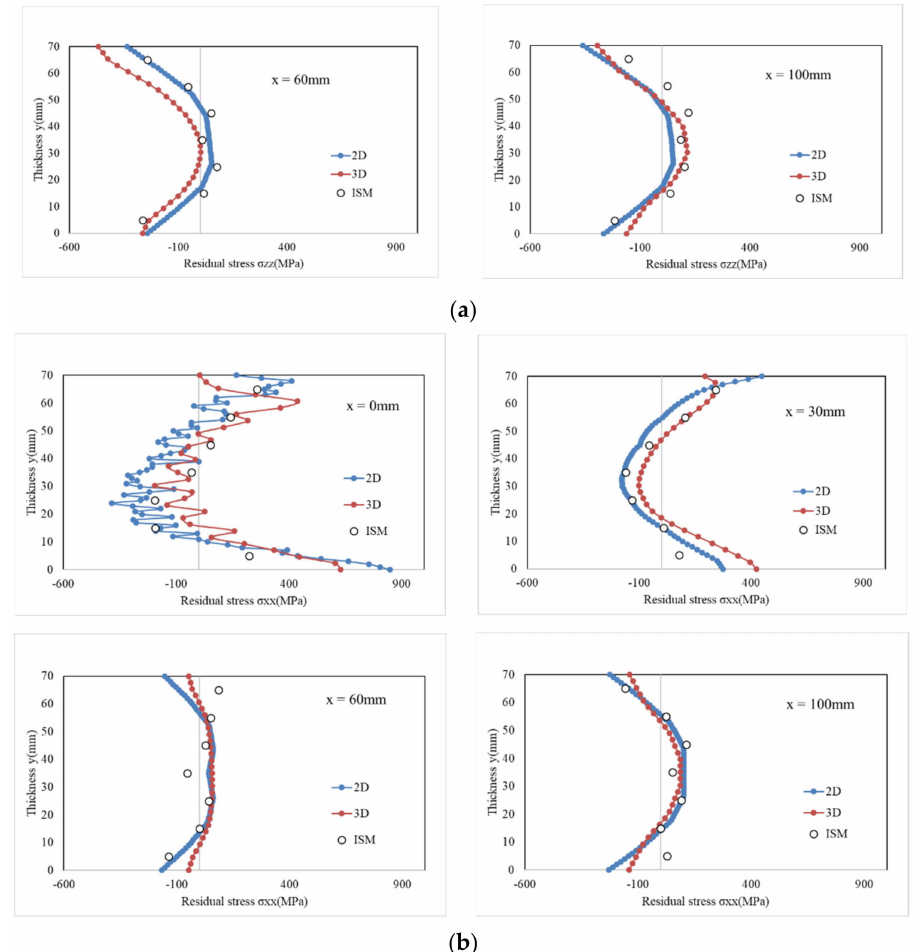
Figure 7. Comparison of residual stress obtained using analysis and experiment: ( a ) longitudinal stress and ( b ) transverse